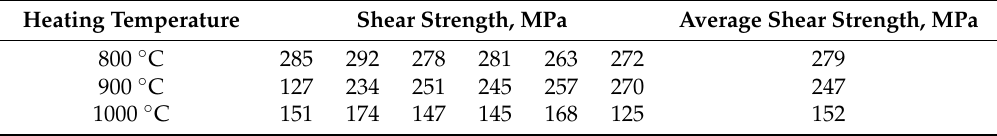
Table 3. The interfacial shear properties of Ti/Nb/steel clad plates at various heating temperatures. Heating Temperature Shear Strength, MPa